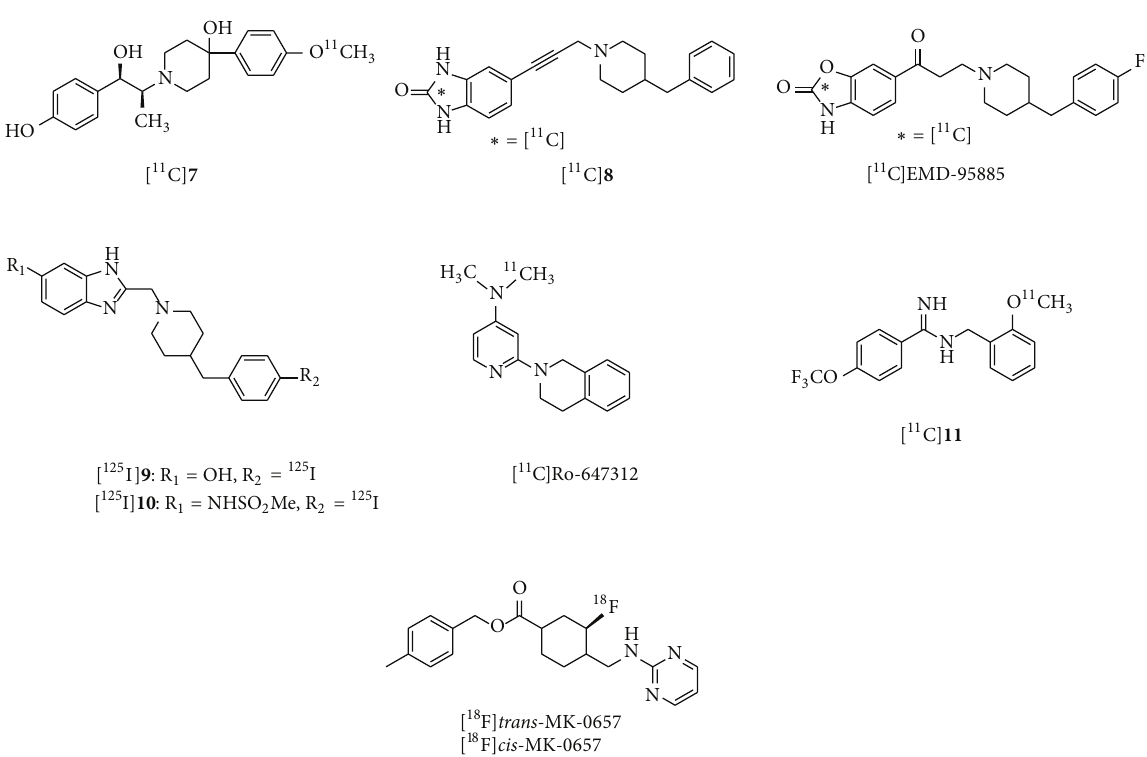
Figure 4: Ex vivo autoradiograms of [ 11 C]L-703,717 in the brain of normal ddY/DAO+ (a) and mutant ddY/DAO-mice (b) 30min after injection of [ 11 C]L-703,717 and warfarin (60 mg/kg) [51].